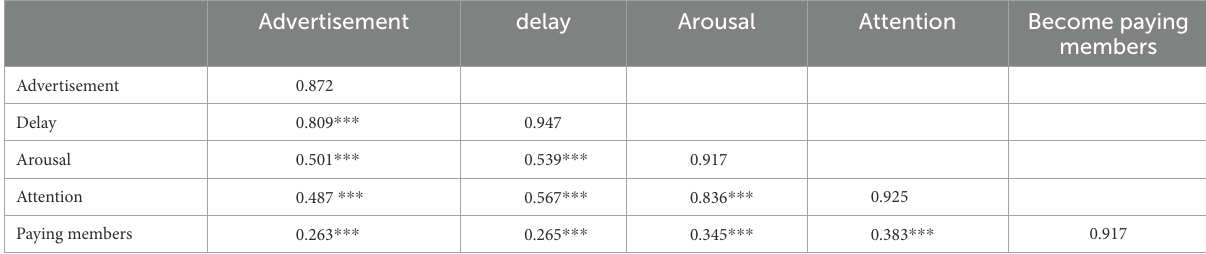
TABLE 3 Discriminant validity of the